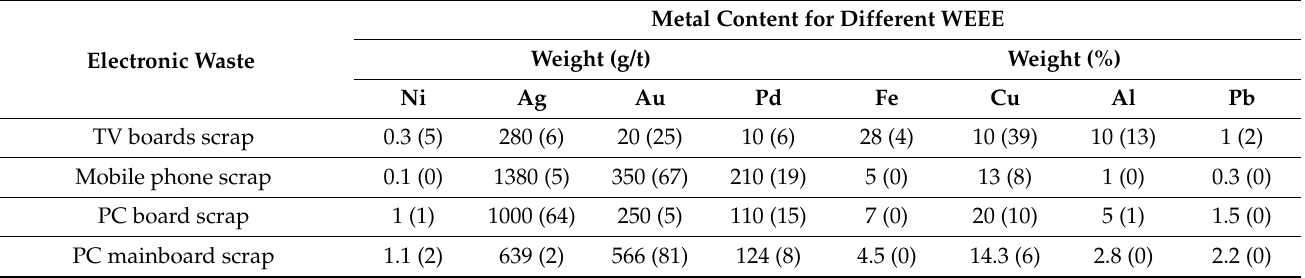
Table 5. Composition of metals found in WEEE by weight [72].